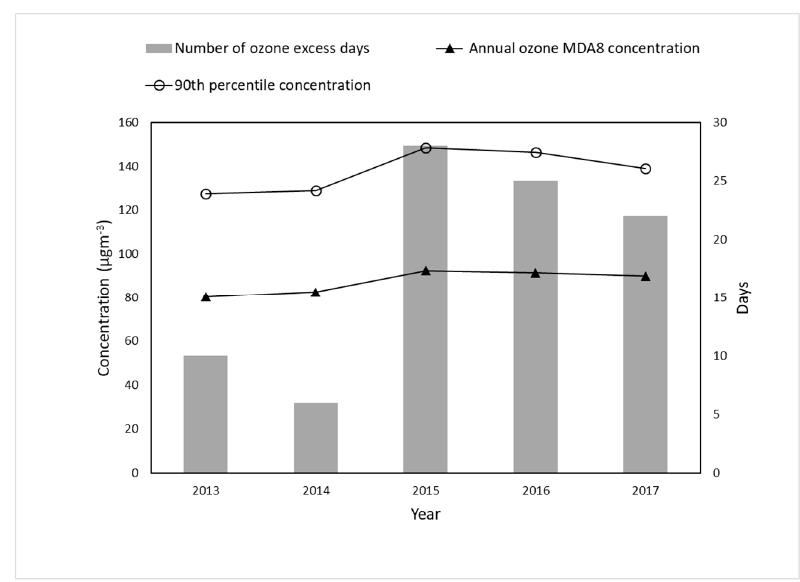
Figure 3. Annual O 3 daily maximum 8 h average (MDA8) concentrations and its 90th percentile variation and the number of O 3 excess days in Changchun from 2013 to 2017.